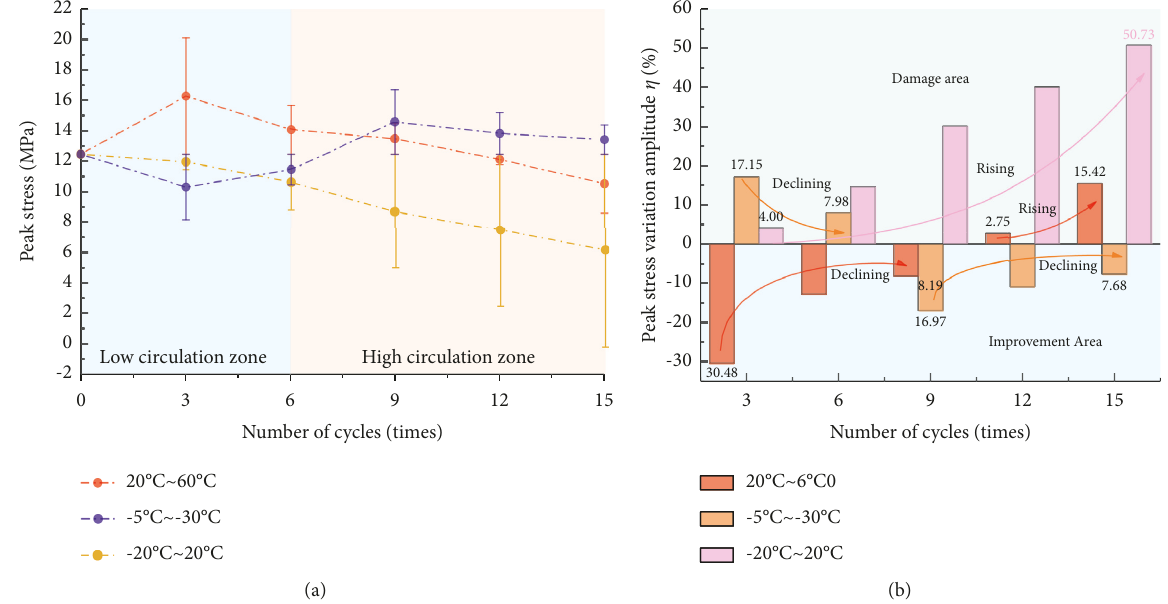
Figure 2: Peak strength of semirigid base at different temperature intervals. (a)Variation of peak stress at different temperature intervals. (b) Variation of peak stress at different temperature